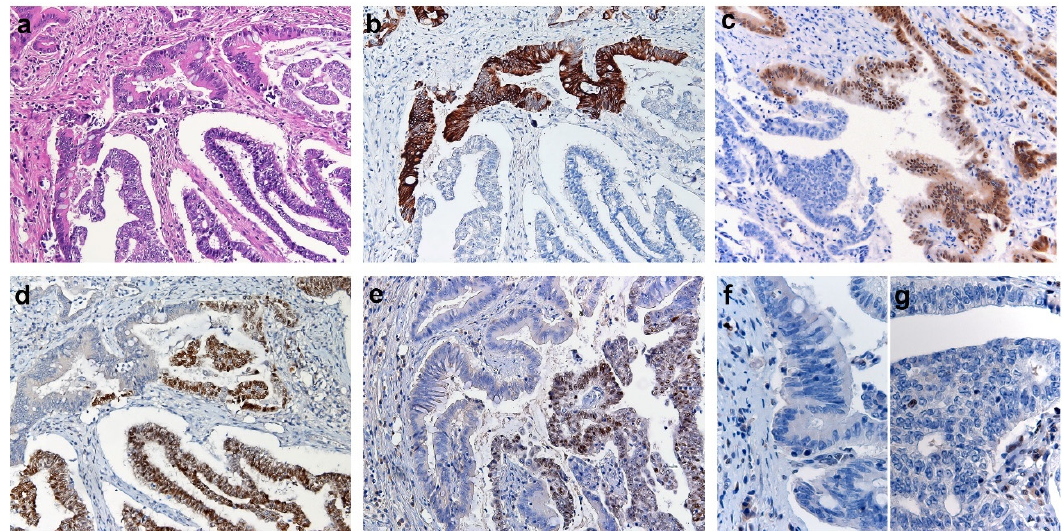
Figure 2. Immunohistochemical features of Endometrial Carcinoma showing intestinal ‐ type features. ( a ) Representative H&E section of the endometrial carcinoma showing two tumor components, the intestinal differentiated one in the upper half and the endometrioid one in the lower half. ( b , c , d , e ) Immunohistochemical stainings for CK20 ( b ), CDX2 ( c ), PAX8 ( d ) and ER ( e ); the intestinal differentiated component (upper half) is positive for CK20 ( b ) and CDX2 ( c ) while negative for PAX8 ( d ) and (ER); the endometrioid component (lower half) shows opposite profile with positivity for PAX8 ( d ) and ER ( e ) and negativity for CK20 ( b ) and CDX2 ( c ). Immunohistochemical staining for MSH6 showing protein loss of expression in the intestinal ( f ) and endometrioid ( g ) tumor